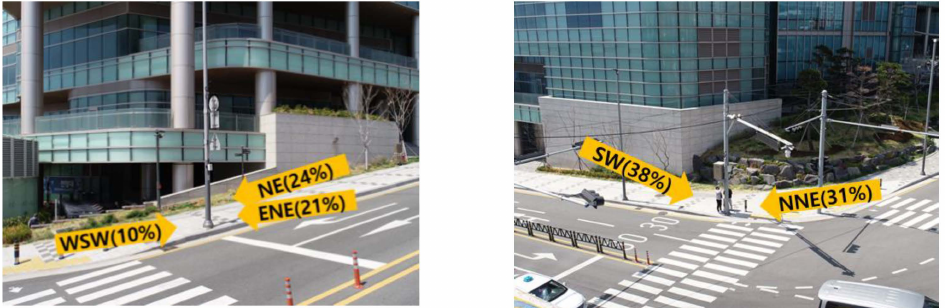
Figure 10. Main wind direction for L-1 ( left ) and L-2 ( right ).